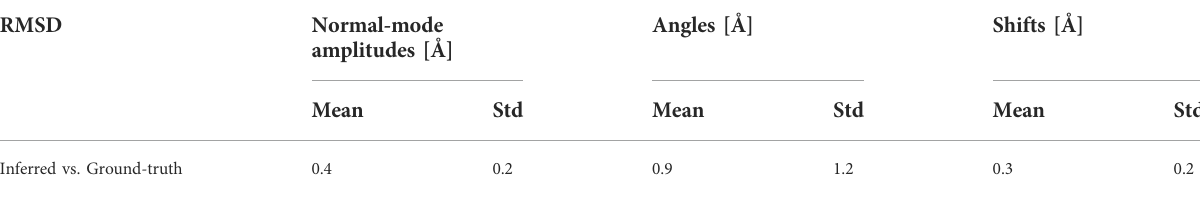
TABLE 4 Mean and standard deviation (Std) of the distance between inferred and ground-truth parameters from Table 3 (for a large test set of 50,000 synthetic images), but expressed in RMSD terms. RMSD